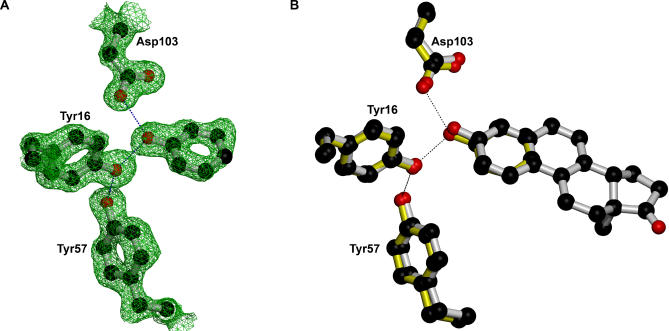
Crystal Structure of Phenolate Bound at the Active Site of pKSI
D40N
(A) Electron density map (1.5 σ) shows that phenolate is bound at the oxyanion hole, receiving short hydrogen bonds from Tyr16 and Asp103.(B) Overlay of the phenolate•KSI structure (yellow) and the intermediate analog equilenin•KSI structure (grey; PDB code 1OGX [
72]) at the active site.